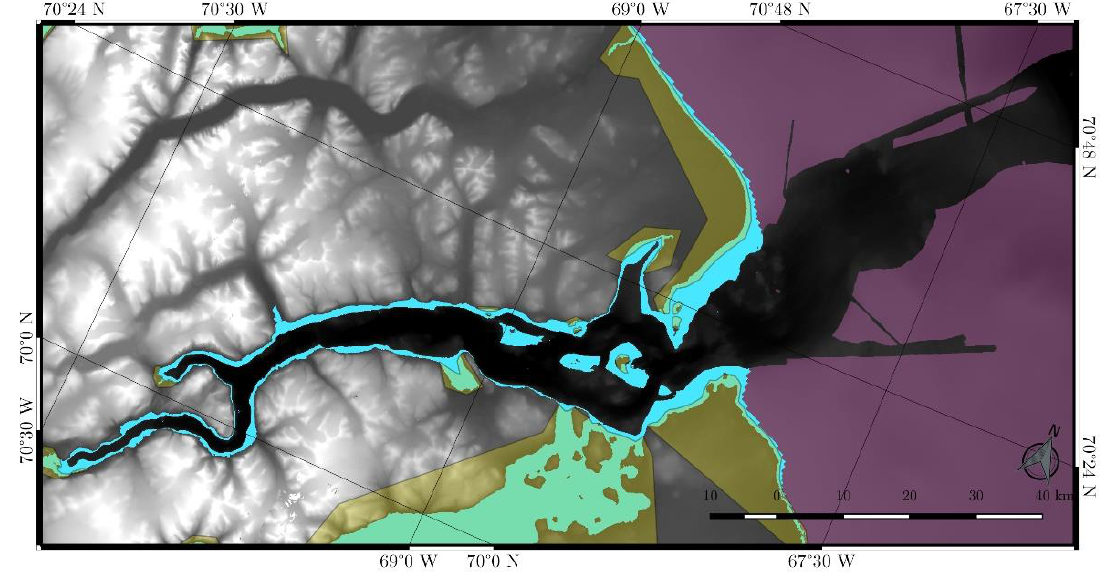
Figure 3. Final digital elevation model (DEM) showing the IBCAO data (pink), interpolated transition (blue) and masks for precarious locations (olive green).